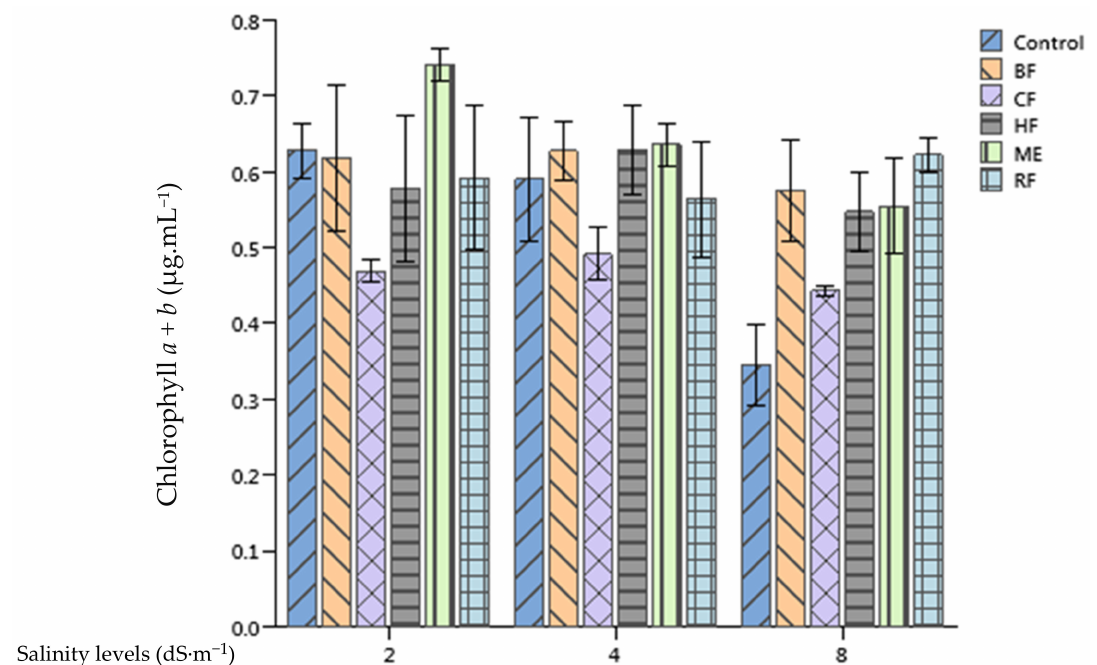
Figure 5. Effect of priming tomato seeds with Ulva lactuca methanol extract (ME), hexane fraction (HF), chloroform fraction (CF), n-butanol fraction (BF), and residual fraction (RF) under different salinity levels (2, 4, 8 dS · m − 1 ) on total chlorophyll content of tomato